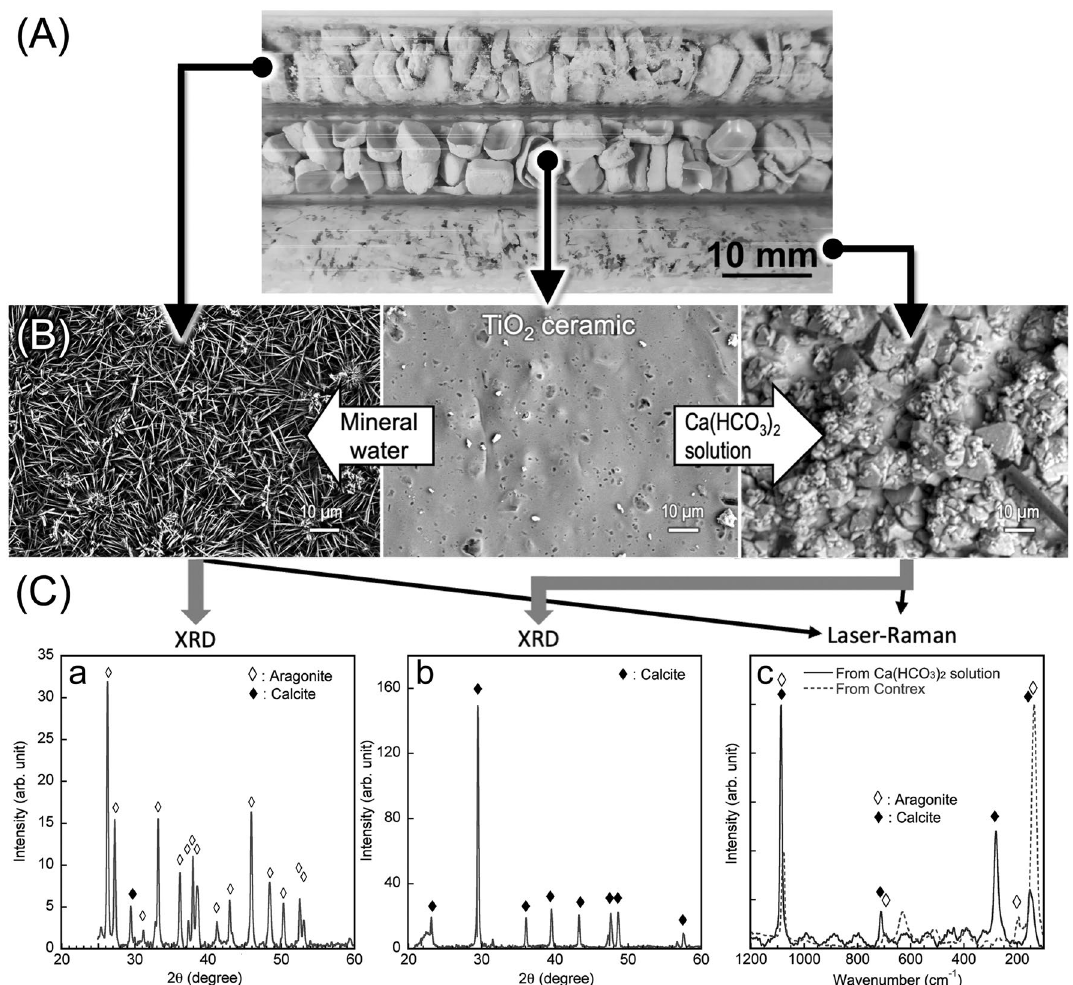
Figure 1. Accumulation states of CaCO 3 onto TiO 2 ceramics. ( A ) Image of the states after mineral water circulation under UV irradiation. Top: Contrex circulated system. Middle: original TiO 2 ceramic. Bottom: Ca(HCO 3 ) 2 solution circulated system. ( B ) SEM images of modified TiO 2 ceramic surfaces by CaCO 3 . Left: TiO 2 modified during Contrex circulation. Center: original TiO 2 ceramic. Right: TiO 2 modified during Ca(HCO 3 ) 2 solution circulation. ( C ) XRD spectra of crystals precipitated from Contrex (a) and Ca(HCO 3 ) 2 solution (b), and Laser-Raman spectra of crystals precipitated from Contrex and Ca(HCO 3 ) 2 solution